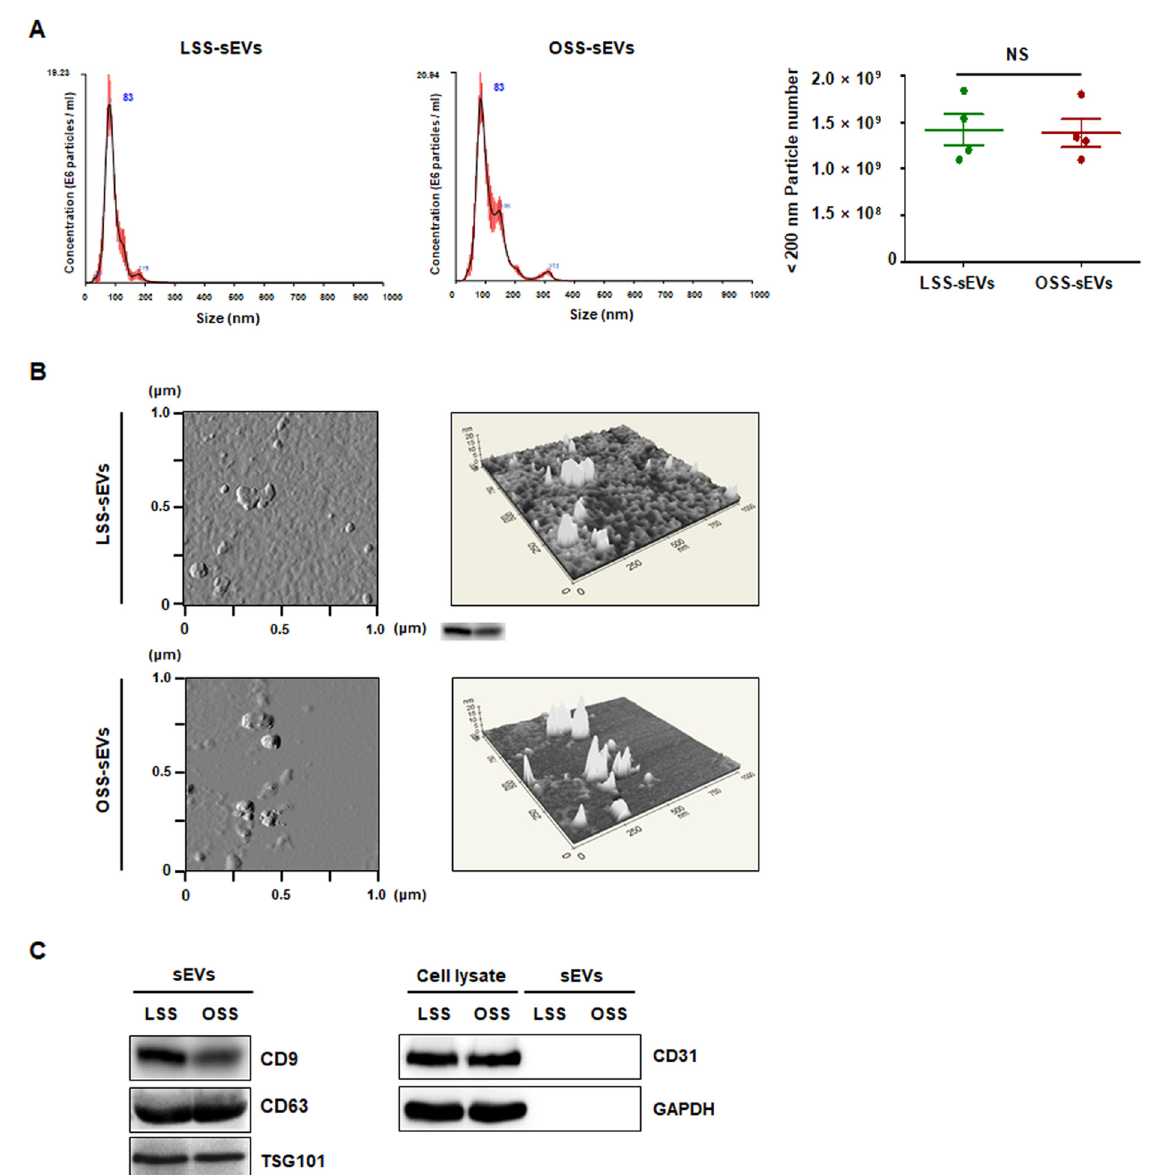
Figure 1. Characterization of EC-sEVs under FSS conditions. Human umbilical vein endothelial cells (HUVECs) were cultured under LSS or OSS conditions for 24 h. Shear stress-induced EC-sEVs (LSS- or OSS-sEVs) were isolated from culture media using ultrafiltration. ( A ) Size distribution of EC-sEVs under FSS conditions was analyzed using NTA. Representative images are shown ( n = 4; NS = no significant). Mean ± standard error of mean (SEM). Statistical analysis was performed using the nonparametric Mann–Whitney U test. ( B ) Isolated shear stress-induced EC-sEVs were visualized with two-dimensional (2D) (left panel) and three-dimensional (3D) (right panel) imaging using AFM. Area scan is 1 × 1 μ m. Representative images are shown. ( C ) Isolated shear stress-induced EC-sEVs were characterized by Western blotting of CD9, CD63, TSG101, CD31, and GAPDH. CD9, CD63, and TSG101 were used as EV markers. CD31 was used as a marker for endothelial microvesicles. Representative images are shown.